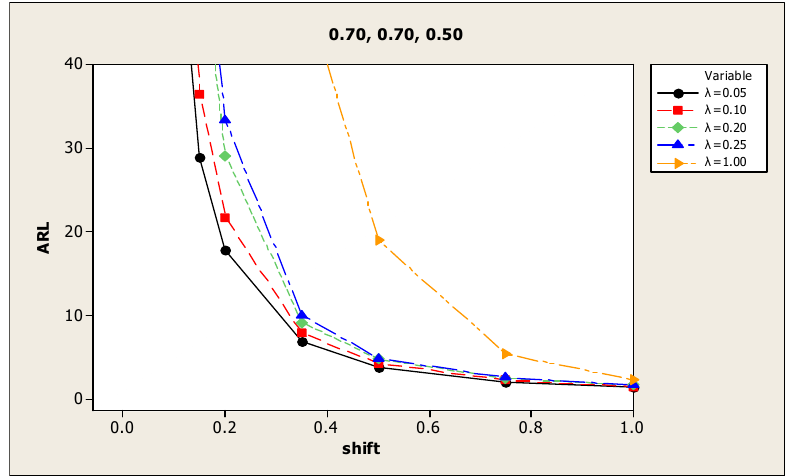
Figure 8. ARL curves when ρ yu = 0.7, ρ yv = 0.7, ρ uv = 0.5 at above values of λ .